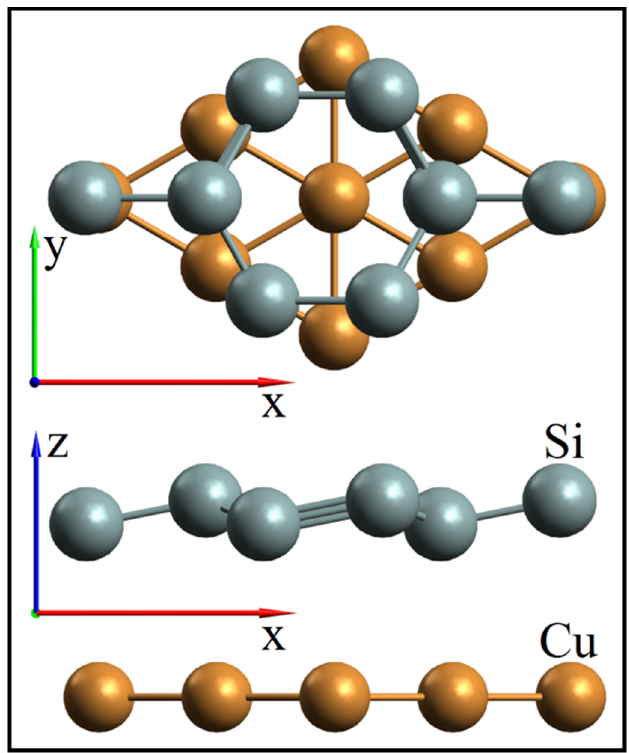
Figure 1. xy ( top ) and xz ( bottom ) projections of combined silicene and copper supercells.